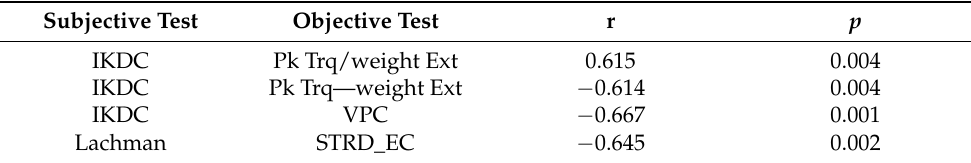
Table 6. Subjective-objective tests correlation. r—Spearman Rho coefficient. p values are indicated. STRD_EC—deviations from the resultant of STR mean axes, eyes closed; VPC—Visual-proprioceptive control